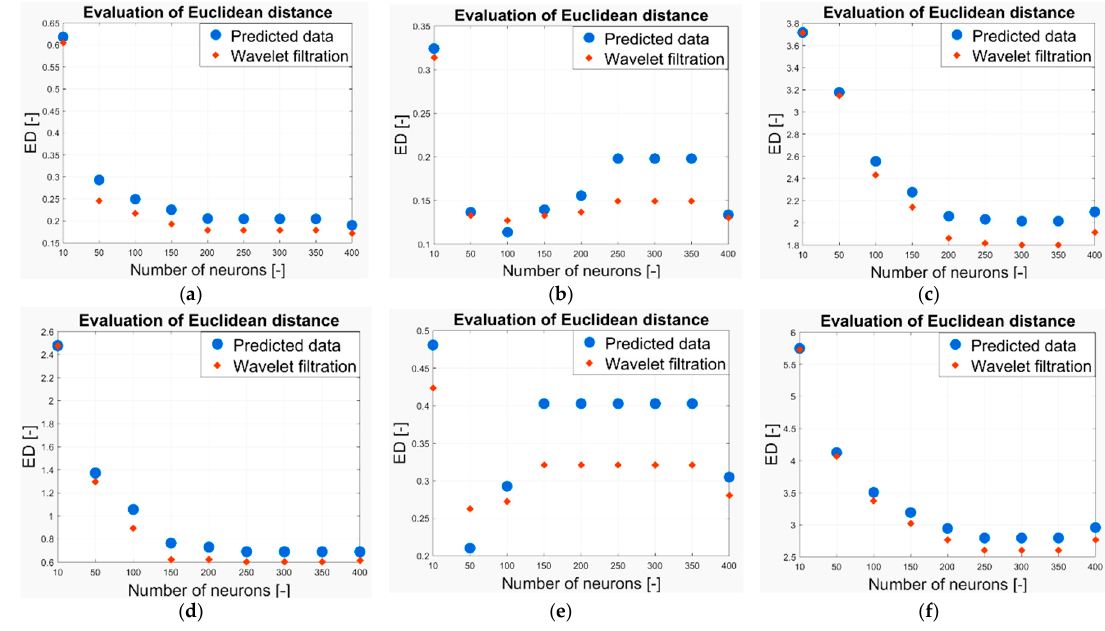
Figure 26. The Euclidean distance evaluation for CO 2 prediction ( a ) 6–13 May 2018, ( b ) 15 May 2018, ( c ) 1–29 May 2018, ( d ) 6–13 November 2018, ( e ) 15 November 2018, ( f ) 4 November–3 December 2018. Table 10. The summarization of the evaluation parameters of the original CO 2 prediction. Date of Prediction MSE [-] Corr [%] ED [-]